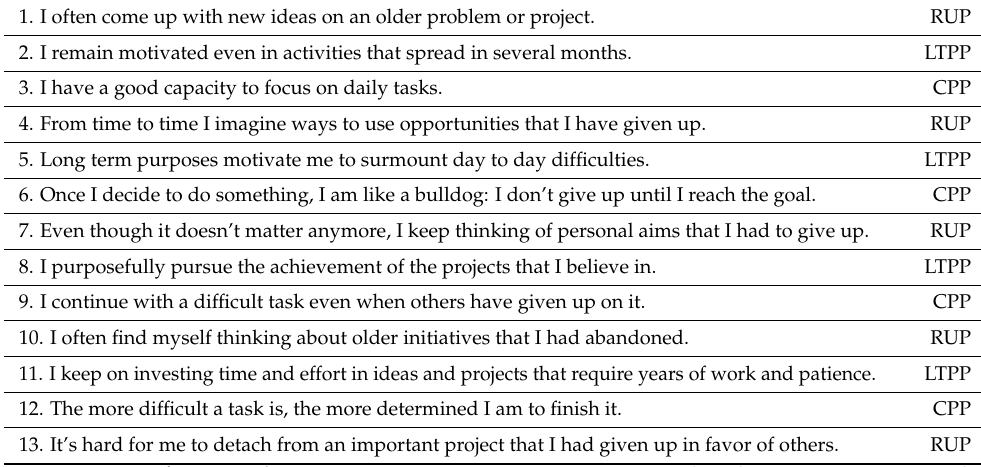
Table 1. List of the items of the Motivational Persistence scale, with indication of the dimension to which each item